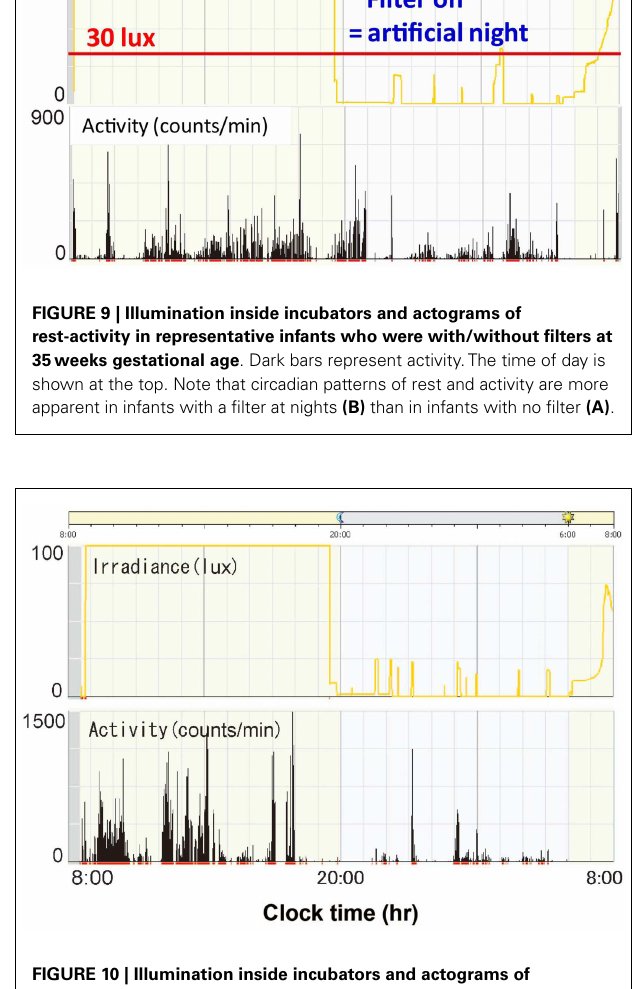
FIGURE 10 | Illumination inside incubators and actograms of rest-activity in a representative infant who were with a filter at 40weeks gestational age . Dark bars represent activity.The time of day is shown at the top. Note that distinct patterns of rest and activity are more apparent in infants of 40weeks gestational age than infants of 35weeks gestational age.